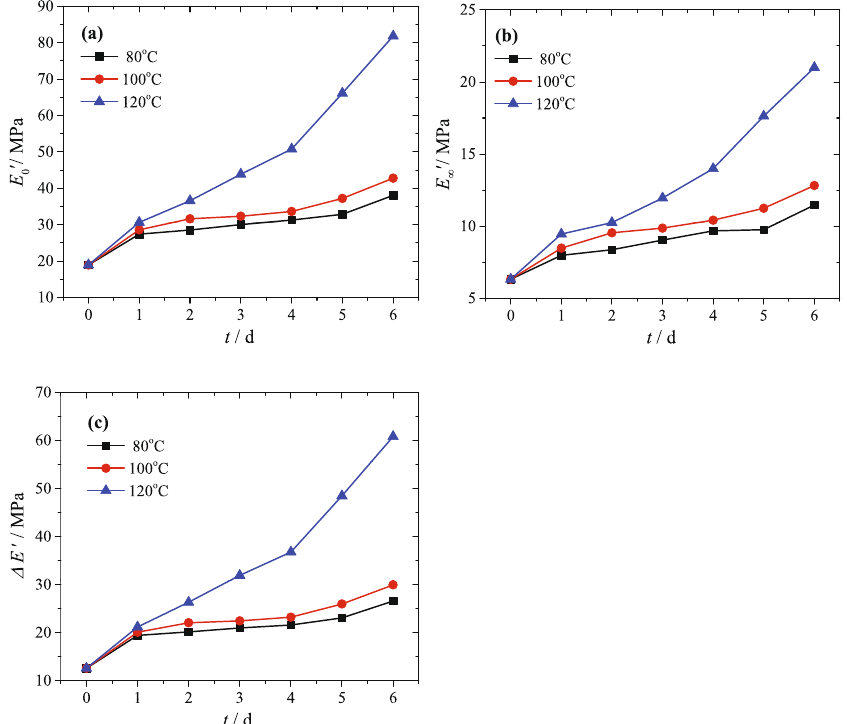
Fig. 3 Changes of Kraus model parameters. a The tendency of the parameter E 0 tendency of the parameter E 0 1 with the aging time for various aging temperatures and c the tendency of the parameter Δ E 0 time for various aging temperatures.